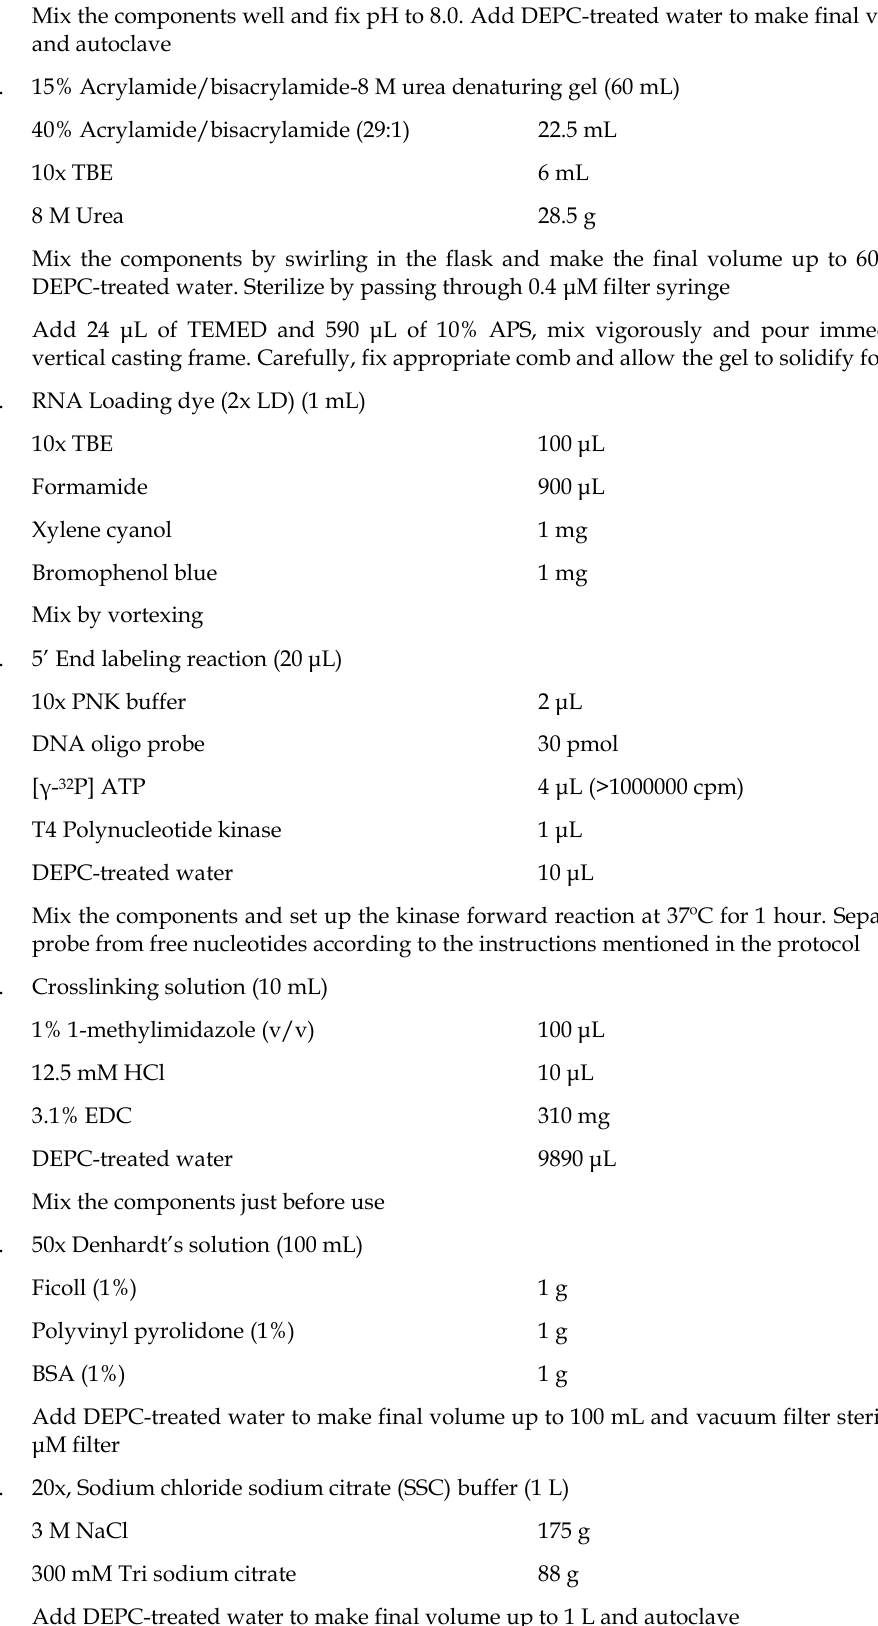
DEPC-treated water 700 mL